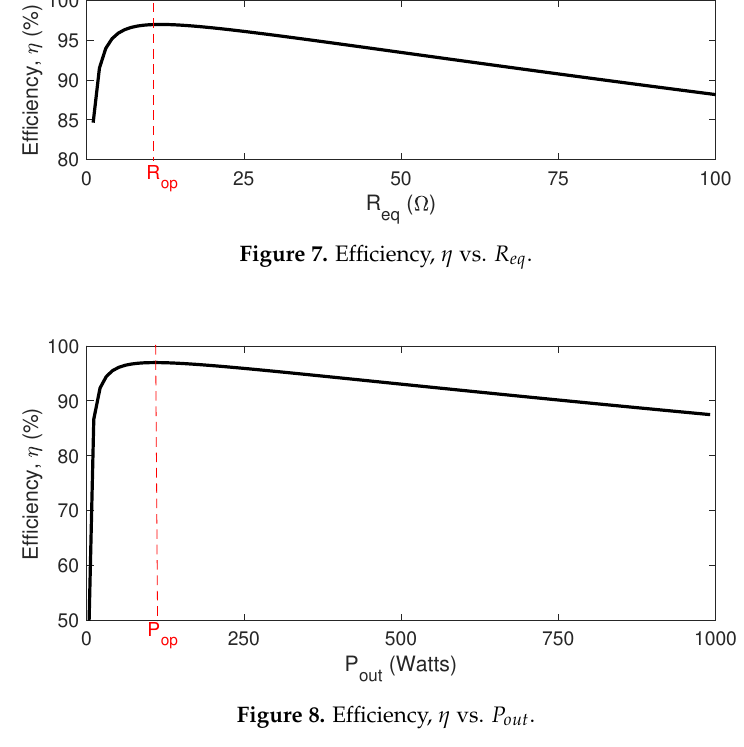
Figure 8. Efficiency, η vs. P out .